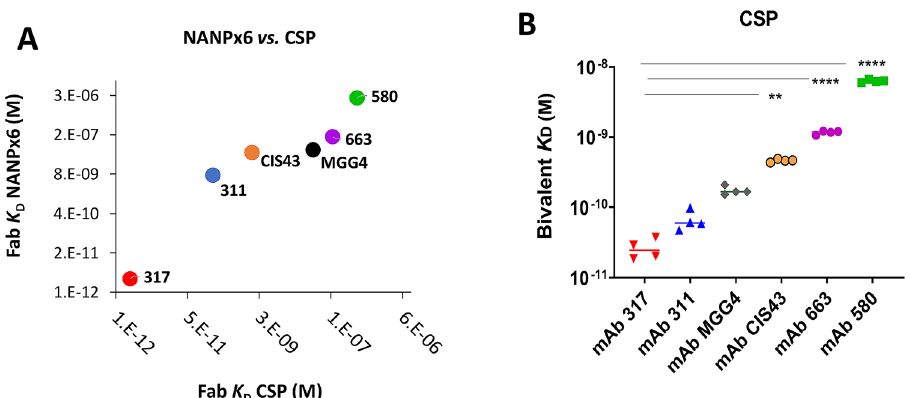
mined by these two methods against both CSP and NANPx6 antigens showed a positive association (Pearson’s coefficient r = 0.8 and 0.9; p < 0.0001; Fig. S4A, B; Table S3). The two avidity assay methodologies confirmed BLI data against both FL-CSP and NANPx6 target antigens that mAb 317 bound its target epitope with the greatest strength. Avidity differences between mAb 317 versus mAbs 580, CIS43, MGG4 and 311 were all statistically significant (Fig. 5; p values < 0.05). MAb CIS43 showed a disproportionately low avidity by ELISA against the NANPx6 peptide (Fig. 5B, D) which was consistent with its preference for the junctional region of CSP. Overall, a slower dissociation rate and a lower dissociation constant corresponded to higher avidity as was alluded to by Dennison et al . 33 ( r = − 0.71, p < 0.0001; Fig. S4C, D; Table S3). In vitro function. Inhibition of liver stage development assay (ILSDA) was performed using P. falciparum sporozoites and primary human hepatocytes. At 5 µg/mL, all CSP mAbs showed inhibitions approaching 100% (Fig. S5). Multiple inhibition assays at 0.5, 0.25 and 0.05 µg/mL were carried out to discern mAb-specific and dose-specific effects (Fig. 6A–C). Due to the intrinsic variability associated with batches of sporozoites and primary human hepatocytes, inhibition data from 3 or more independent ILSDA experiments for each mAb were fitted to a General Linear model and least square mean estimates were statistically compared (Table S4). Compared to the control mAb 3G1, at 0.5 and 0.25 µg/ml all the CSP mAbs inhibited invasion of P. falciparum sporozoites (Table S5; p values < 0.0001). CIS43, MGG4 inhibition was significantly higher than the control mAb even at the lowest dose level of 0.05 µg/ml ( p < 0.0001) (Fig. 6C; Table S5). In pairwise comparisons between CSP mAbs, CIS43 displayed ~ 99% inhibition at 0.5 µg/ml that was significantly higher than mAbs MGG4, 311, 317, 580 and 663 (all p values < 0.05, Fig. 6A; Table S6). At 0.25 µg/ml, mAb CIS43 displayed 92% inhibition that was statistically superior to mAbs MGG4, 580, 663, 311 (Fig. 6B; Table S6, p values < 0.002). At 0.05 µg/ml dose mAb, CIS43 inhibition remained above mAbs 663, 580, 317 and 311 (Fig. 6C; Table S6; p values < 0.05). Overall, mAb